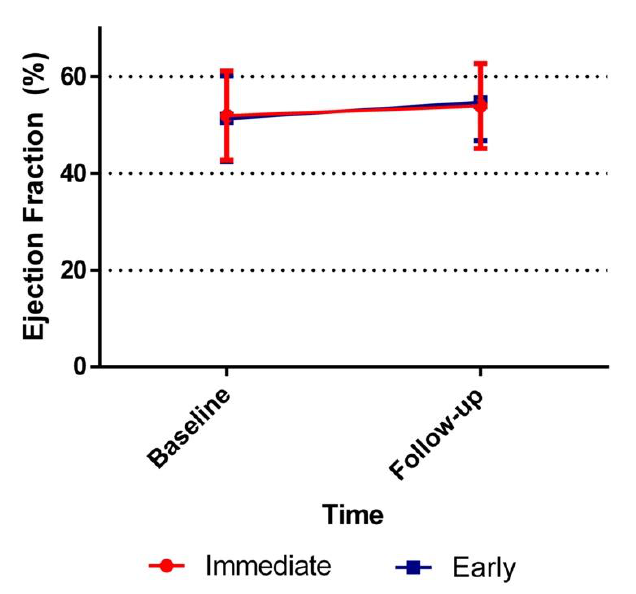
Figure 2. Ejection fraction improvement over time. The ejection fraction of both the immediate invasive strategy and early invasive strategy groups at baseline and at 30-day follow-up. Table 3. Comparison of Left Ventricular Global Longitudinal Strain for ACS-patients.